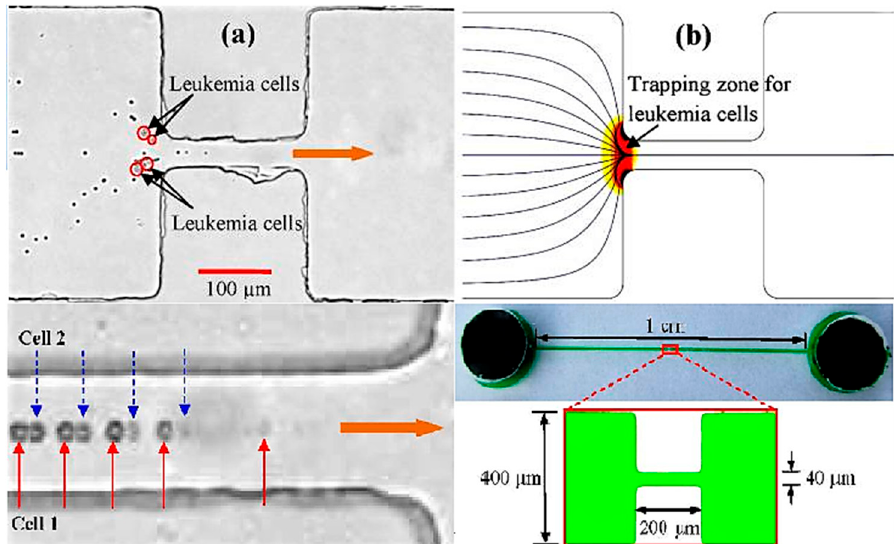
Figure 17. (top) Integration of electrical concentration of leukaemia cells and electrical lysing of red blood cells in the microchannel constriction: (a) experimentally recorded snapshot image with the trapped leukaemia cells highlighted with circles for clarity and (b) numerically predicted trapping zone for leukaemia cells and trajectories for red blood cells. The block arrow indicates the flow direction. (bottom left) Superimposed image of two red blood cells (highlighted as cell 1 and cell 2) illustrating the typical process of electrical lysis in the microchannel constriction. The block arrow indicates the flow direction in the channel. (bottom right) Picture of the microfluidic chip and dimensions of the constriction microchannel. (Re-printed from Church et al. [131]. Copyright (2010), with permission from The American Institute of Physics).